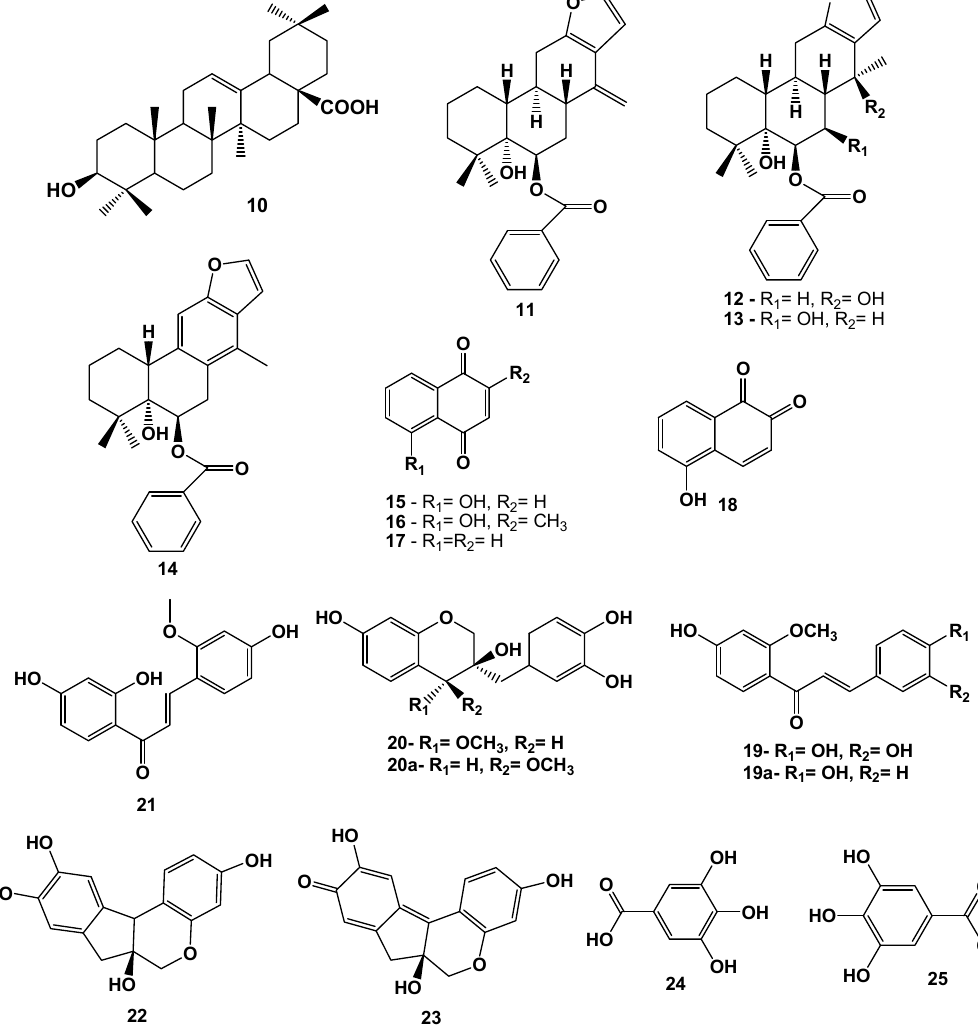
Figure 2. Triterpenoids, naftoquinones and phenolic compounds from species of Caesalpinia showing antimicrobial, antioxidant, antitumoral and citoprotective